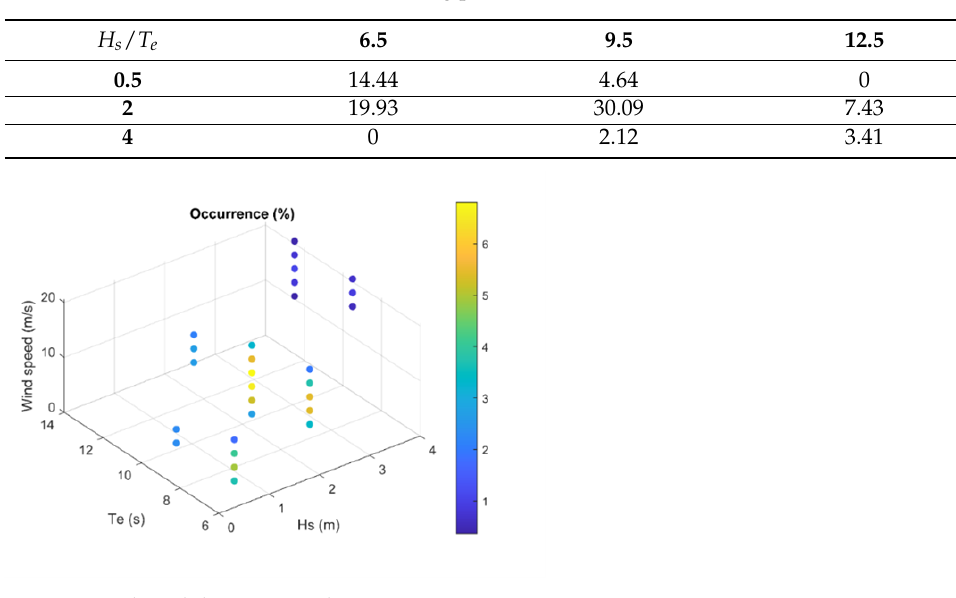
Figure 18. Decade data set triplets (Hs Tp V0) against the occurrence values. Table 7. Reduced scatter matrix after filtering process